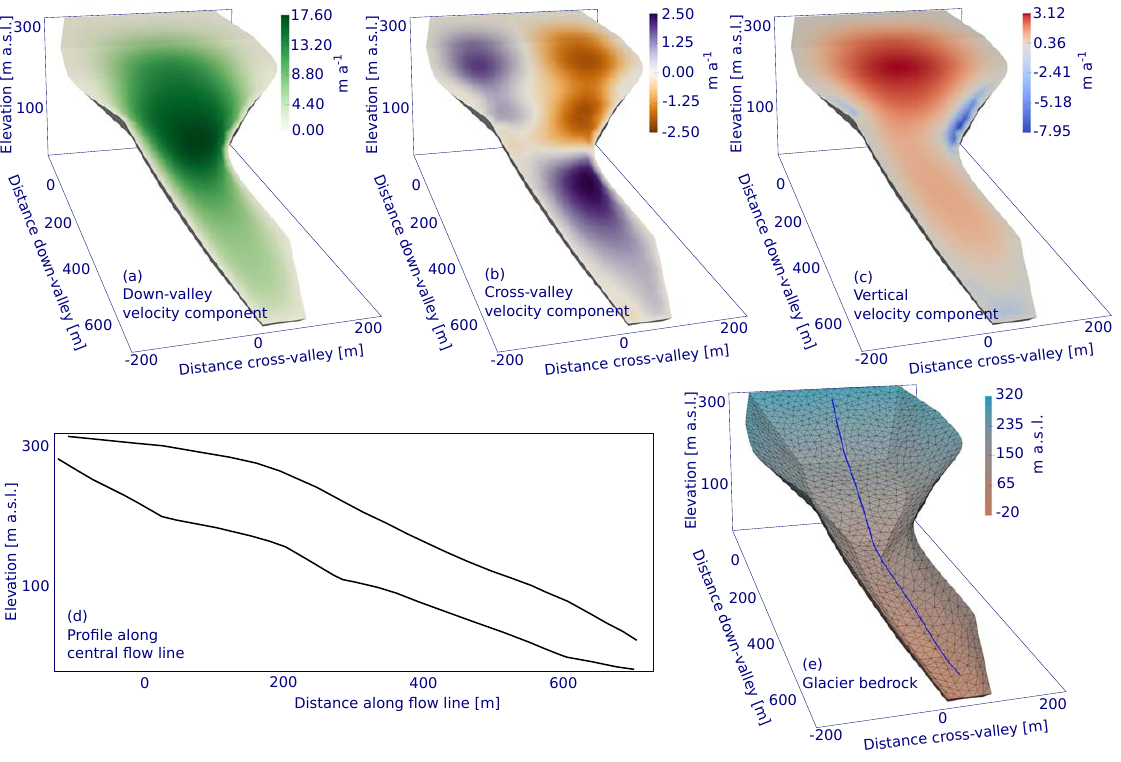
Figure 5. Idealized geometry and computed velocity components (myear − 1 ) for the 3-D glacier case. (a) Down-valley direction (along x axis), (b) cross-valley direction (along y axis) and (c) vertical direction (along z axis), (d) 2-D profile along a central flow line and (e) glacier bedrock elevation and flow line from (d) in